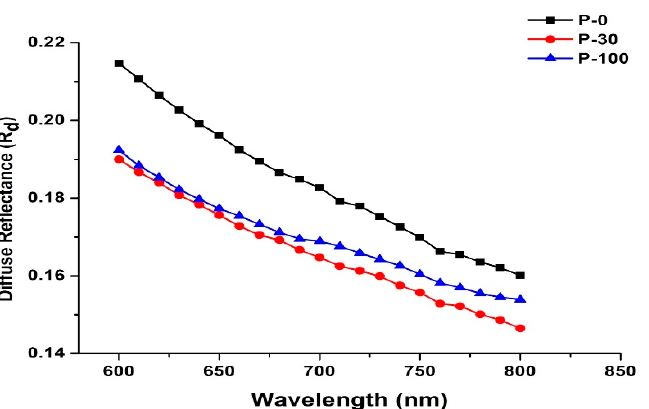
Figure 1. Experimental values of diffuse reflectance over the spectral range of wavelength from 600 nm to 800 nm.